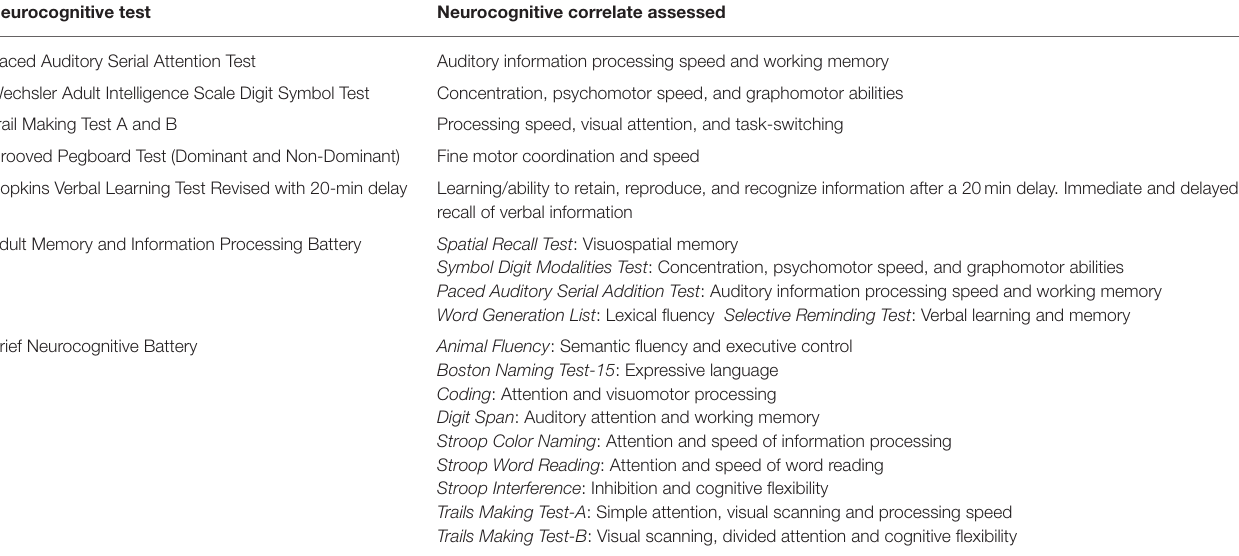
TABLE 4 | Neurocognitive tests and cognitive domains. Neurocognitive test Neurocognitive correlate assessed Paced Auditory Serial Attention Test Auditory information processing speed and working memory Wechsler Adult Intelligence Scale Digit Symbol Test Concentration, psychomotor speed, and graphomotor abilities Trail Making Test A and B Processing speed, visual attention, and task-switching Grooved Pegboard Test (Dominant and Non-Dominant) Fine motor coordination and